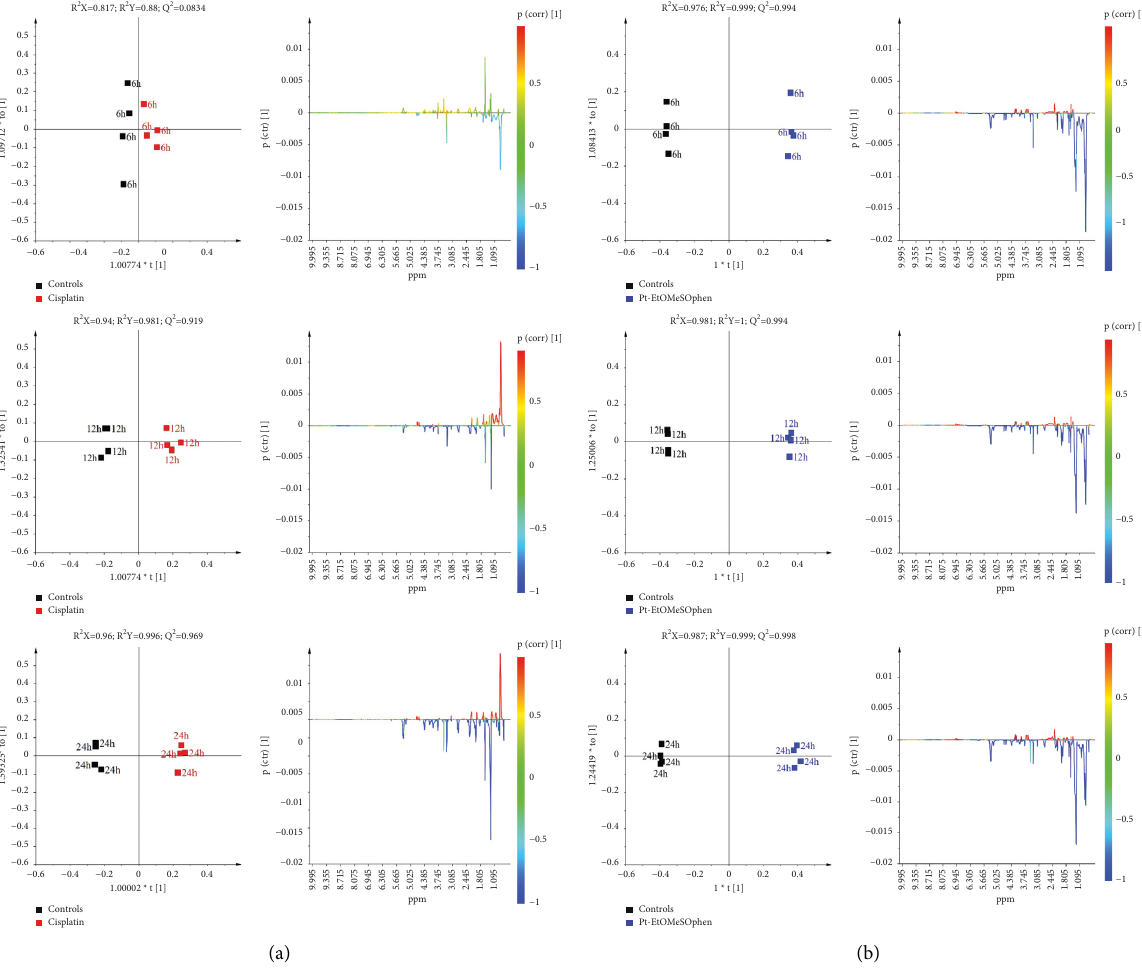
Figure 4: Time response pairwise comparison OPLS-DA score plot models (1+2+0 components) and corresponding color-coded correlation coefficient S-line plots displaying the related predictive discriminant loadings variables derived from 1 H NMR spectra of SH- SY5Y cells lipid extracts obtained from different pairwise groups. (a) Controls vs. cisplatin. (b) Controls vs.